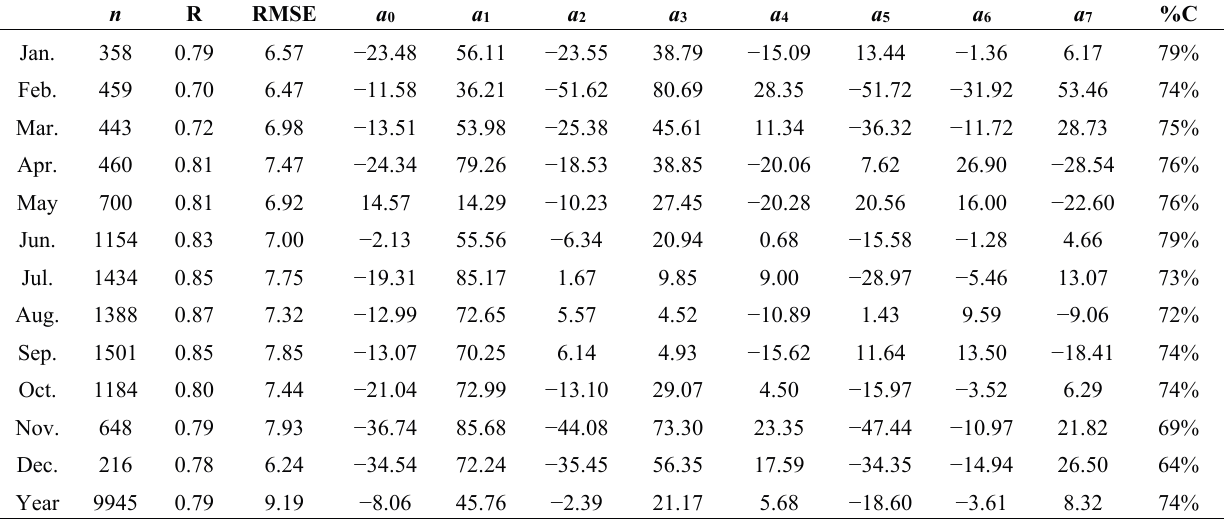
Table 1. Derived coefficients using linear precipitable water vapor (PWV) retrieval algorithm: n is the number of data pairs used for regression; R is the Pearson correlation coefficient; RMSE is the root mean square error of the regression; a 0 to a 7 are the partial regression coefficients; % C is the percentage of cloudy pixels over the radiosonde sites in each